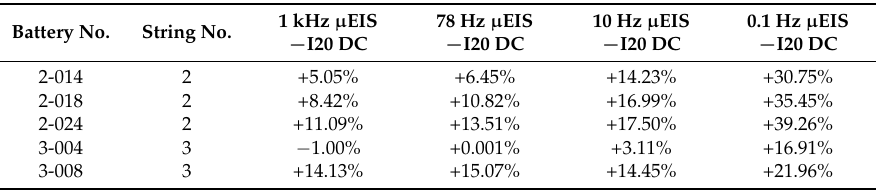
Figure 6. Increase of the normalized impedance |Z| measured at four different frequencies (1 kHz, 78 Hz, 10 Hz and 0.1 Hz) with superimposed DC current over time of the test for all check-ups of battery 2-014 of String 2. Table 5. Summary of relative change of the impedances registered by the μEIS over 568 days at different frequencies for all investigated batteries.